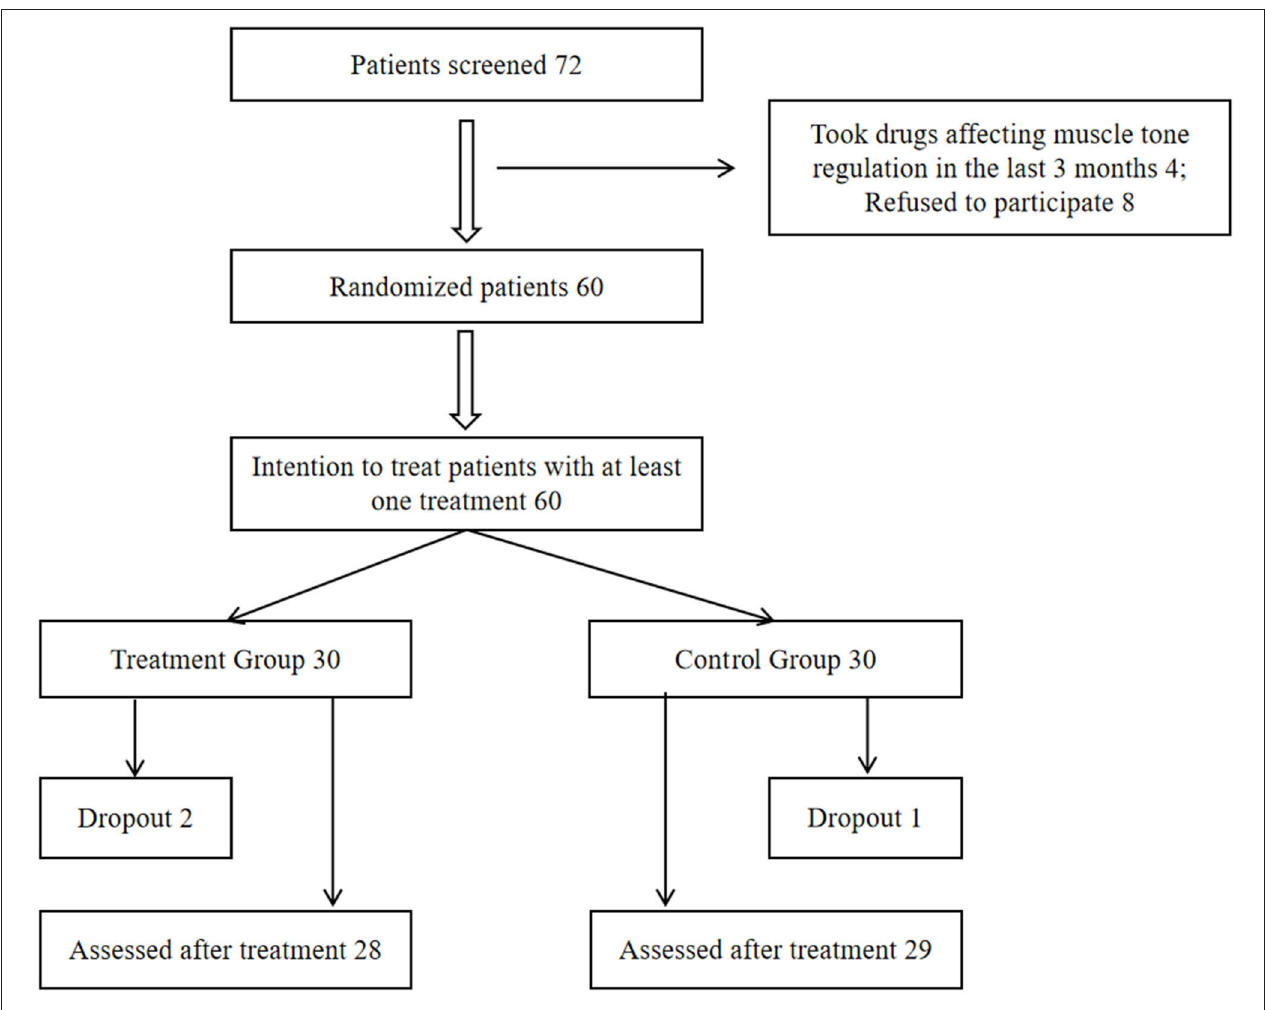
FIGURE 2 | Flow chart of the study